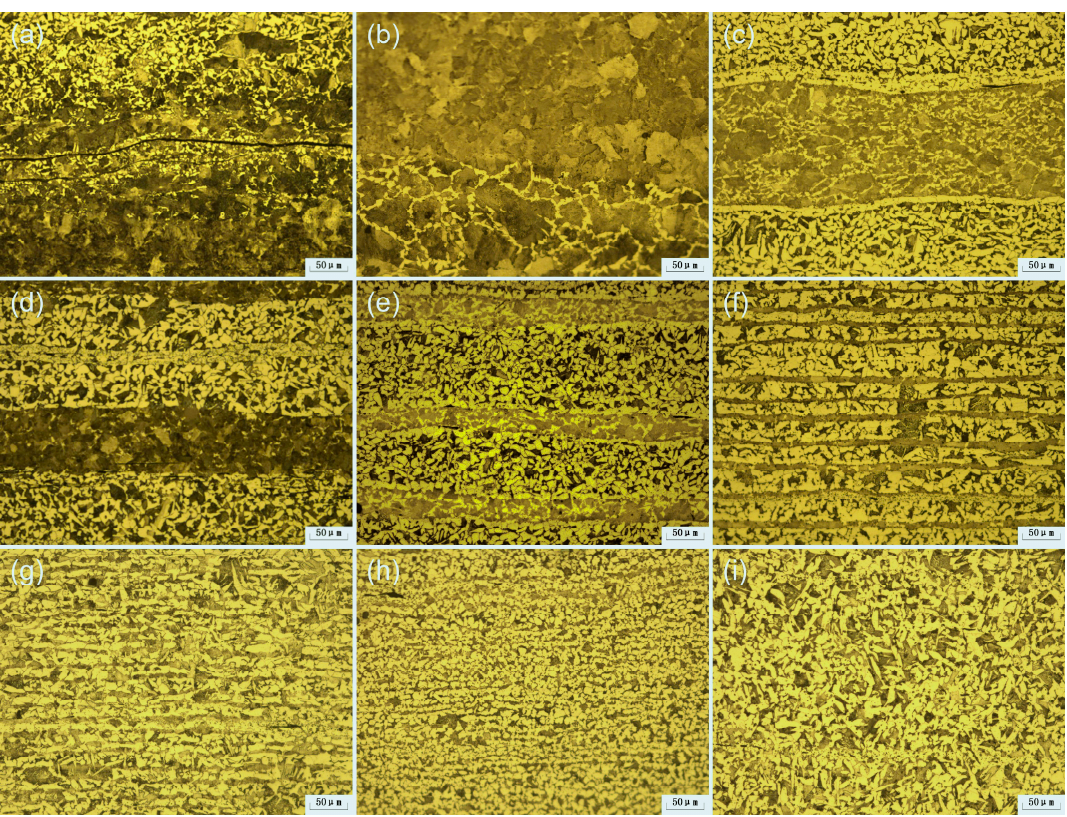
Figure 6. Continuous microstructural evolution of group 3, 200 magnification: ( a ) smelting; ( b – i ) forge welding 1–8 times.